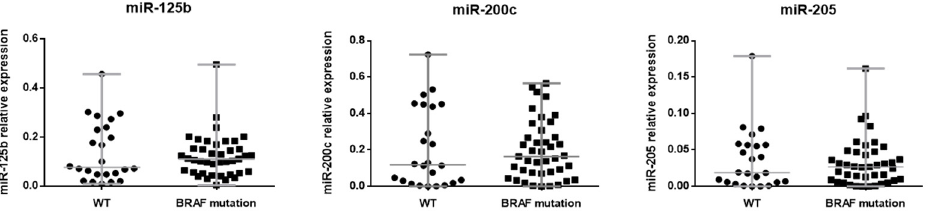
Figure 2. Relative expression of miR-125b, miR-200c and miR-205 according to the mutational status of BRAF (WT or any BRAF mutation).